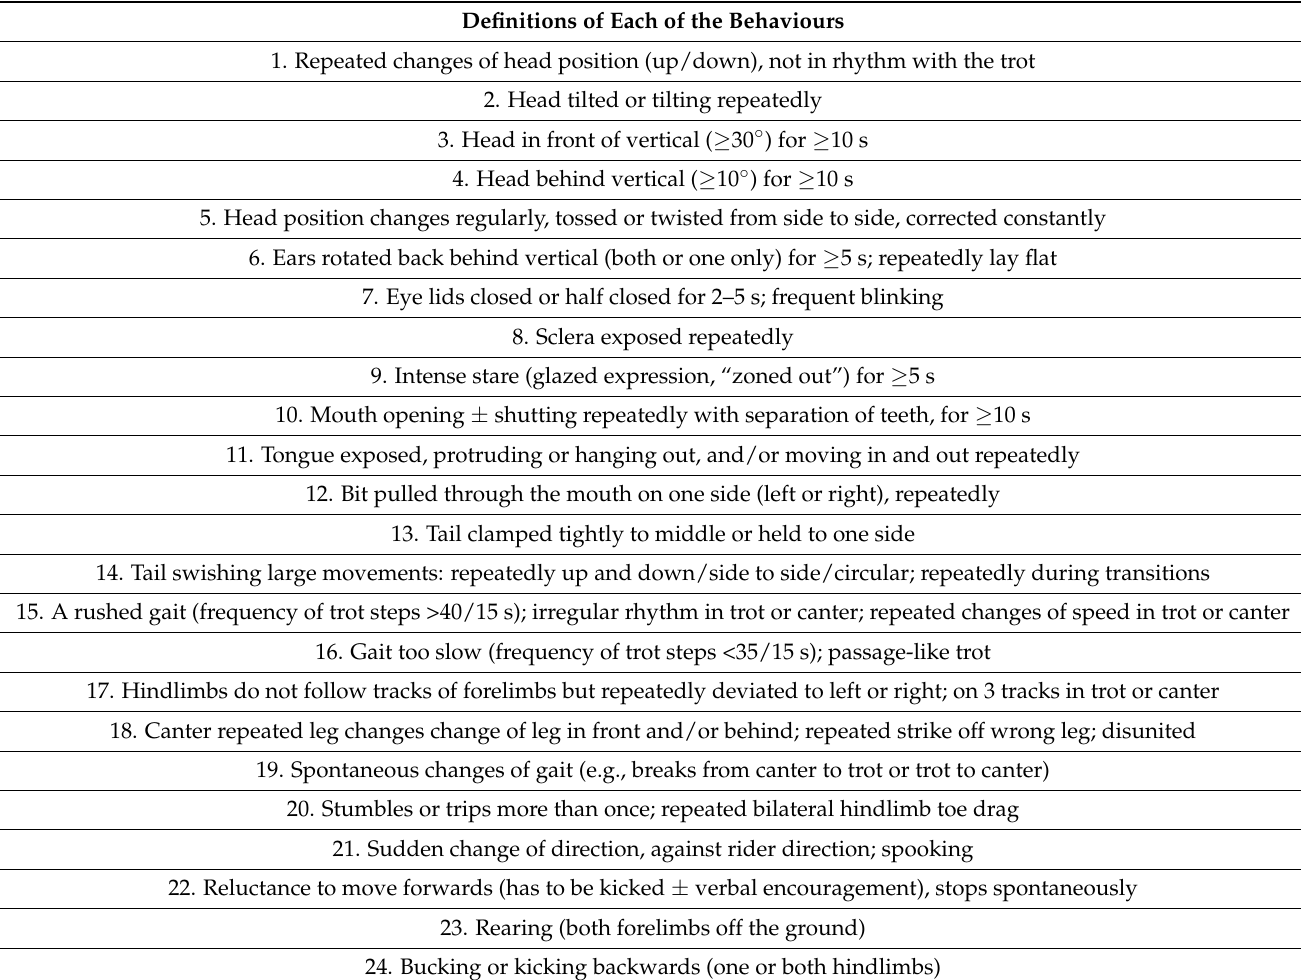
Table 1. Summary of the 24 behaviours of the Ridden Horse Pain Ethogram (adapted from Dyson et al. [1]). Definitions of Each of the